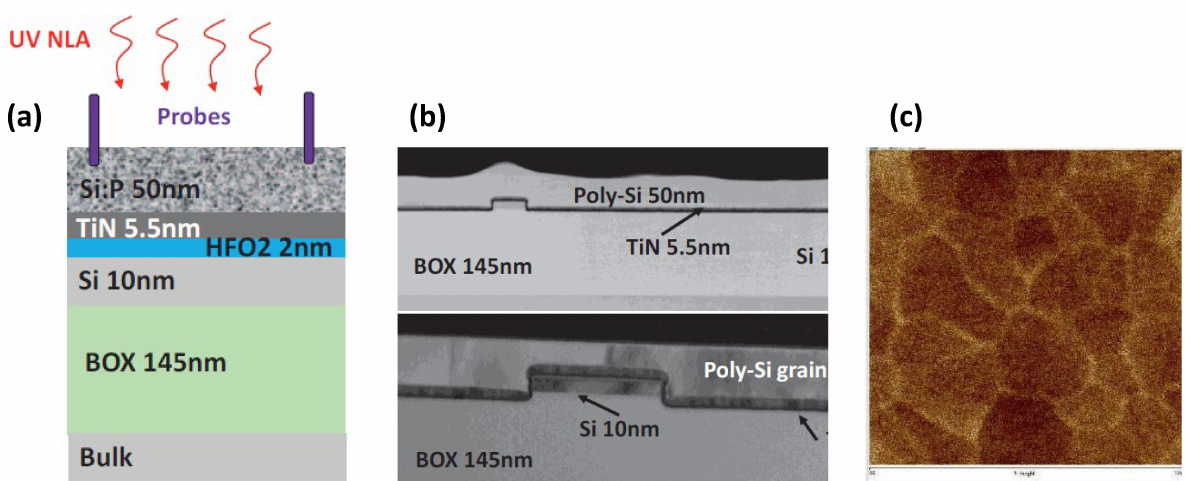
Figure 18. ( a ) Schematic of ns UV-LA in a 3D type structure having an amorphous Si layer on the top, ( b ) cross-sectional TEM images taken in the test structure followed by ns UV-LA and top amorphous Si melting then by CMP to planarize the top surface, ( c ) atomic force microprobe image taken after the CMP planarization. Reprinted/adjusted with permission from Ref. [1]. 2018,